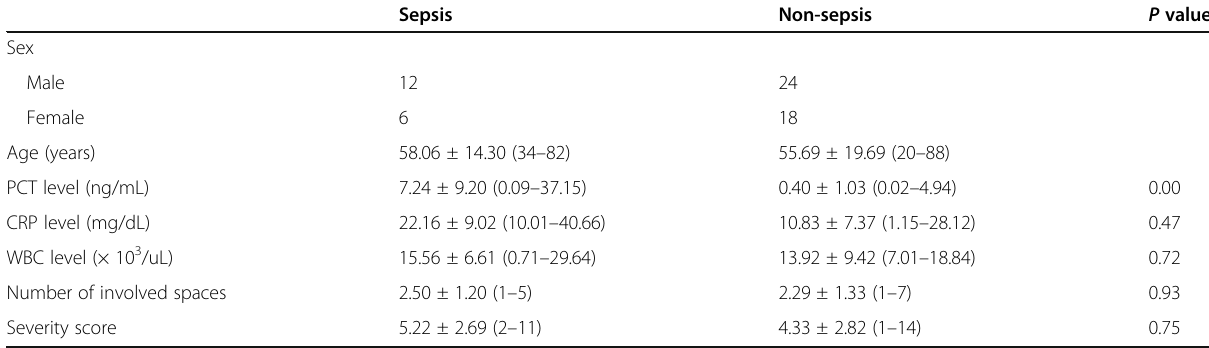
Table 2 Demographics; procalcitionin, C-reactive protein, and white blood cell level on admission; number of spaces involved; and severity score of the sepsis and non-sepsis groups Sepsis